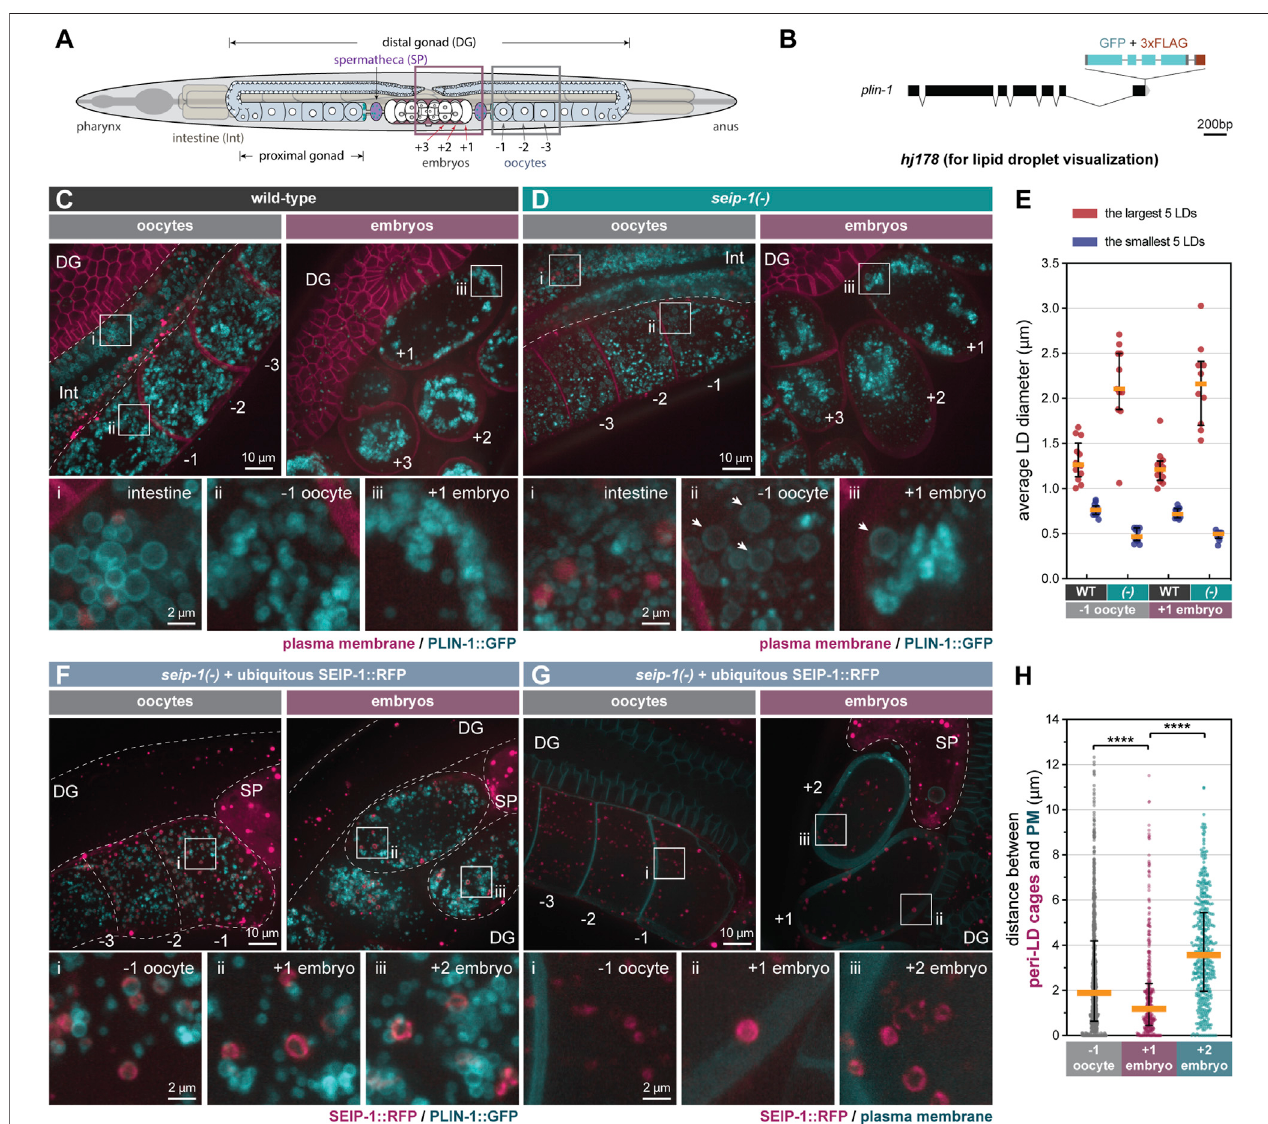
FIGURE2| SEIP-1 localizesto peri-lipid droplet (LD) cages and regulates LDmorphology in thegermline. (A) The anatomy ofanadult-stage C. elegans .Plum and grey boxes frame the region of interest (ROI) for imaging embryos and oocytes, respectively. (B) Schematic representation of a plin-1(W01A8.1) knock-in allele (hj178). Two isoforms of PLIN-1 (PLIN-1a and c), but not PLIN-1b, are fused with GFP at the C-terminus. (C) Visualization of LDs using PLIN-1::GFP (hj178) in a 1-day-old wild- type (WT) adult. mCherry::PH(PLC1 δ 1)( ltIs44 ) labels PMinthegermline.mCherry and GFPare pseudocolored magenta and cyan, respectively. Dotted lines mark theboundarybetweendifferenttissuesorembryos.Boxedregionsweremagni fi ed×5anddisplayedatthebottom. Aprojectionof4.5 μ mzstackreconstitutedfrom10 focal planes is shown. For anatomical positions of the ROI, refer to (A) . (D) as in (C) , but with a seip-1(-) mutant. Arrows point to aberrantly enlarged LDs. (E) Average diameterofthelargest(crimson)orsmallest(navy-blue) fi veLDsinindividual1-day-oldadults.Atleast10animalsofeach genotypewerescored.(-)represents seip-1(-) . In both oocytes and embryos, when compared to WT, the difference between crimson and navy-blue dots is augmented in seip-1(-) . (F) as in (C) , but with a 1-day-old adult seip-1(-) that expressed SEIP-1::tagRFP ( hjSi434 ) and PLIN-1::GFP ( hj178 ). The hjSi434 transgene rescues the embryonic defect in seip-1(-) ( Supplementary FiguresS3D,E ).mCherryandGFParepseudocoloredmagentaandcyan,respectively. (G) Asin (F) ,butwitha1-day-oldadult seip-1(-) thatexpressedSEIP-1::tagRFP ( hjSi434 )andGFP::PH(PLC1 δ 1)( itIs38 ). (H) TheshortestdistancebetweenindividualSEIP-1::tagRFPlabelledperi-LDcagestoPM.Atleast151-day-old hjSi434 ; seip- 1(-) adults were scored. Number of peri-LD cages analyzed: − 1 oocytes = 829; +1 embryos = 383; +2 embryos = 414. **** p < 0.0001 (ordinary one-way ANOVA with Turkey ’ s multiple comparisons